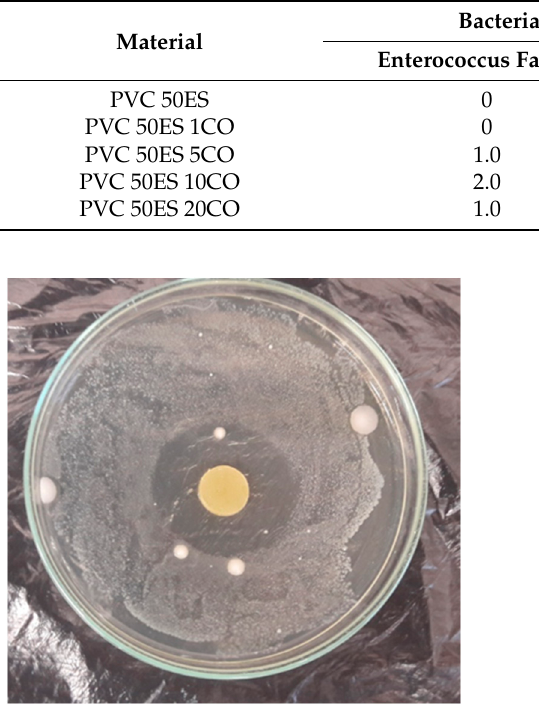
Figure 10. L. monocytogenes inhibition zone of PVC 50ES 10CO.